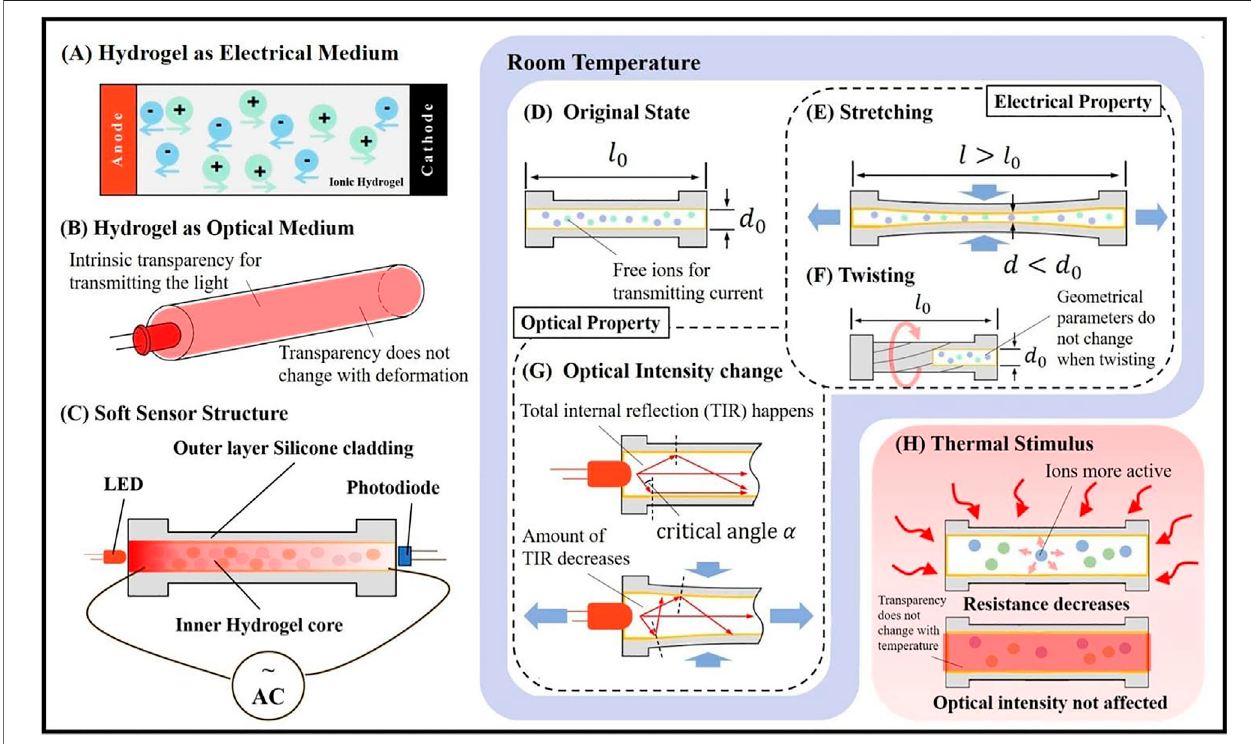
FIGURE 2 | Electrical and optical properties of ionic hydrogel. (A) Ions in hydrogel make it a conductive material and resistively detectable. (B) The intrinsic transparencyofhydrogelenableslighttotransmitthroughthecore,whichdoesnotchangewithdeformation. (C) ThestructureoftheMHSSensor.LEDandphotodiode are at the two distal ends of the cylindrical silicone cladding respectively. The resistance of the hydrogel core and the optical intensity received by the photodiode are measured to re fl ect the deformation. (D) The original state of the MHS Sensor. (E) The resistance of the hydrogel core will increase with the length rising and diameter decreasing when being stretched. (F) The resistance will not change when being twisted, as the change in geometrical parameters of the hydrogel core is negligible. (G) The received optical intensity can be detected changing, as the amount of the total internal re fl ection will decrease during deformation. (H) Under thermal stimulus, free ions of the hydrogel will be more active leading to resistance decreasing, while the transparency will not change, which means that temperature does not affect the optical intensity received.